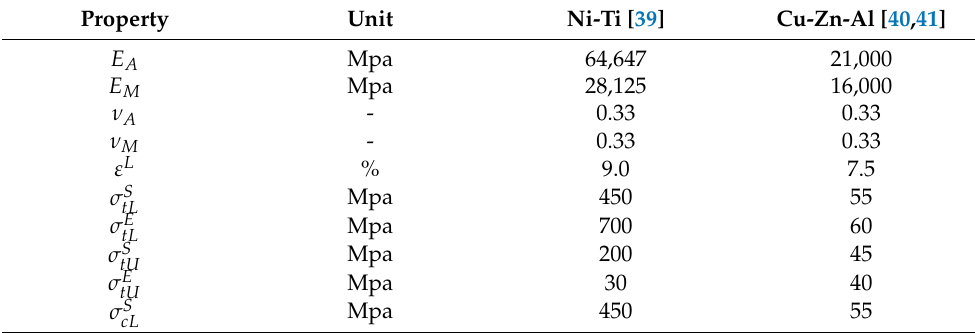
Table 2. Properties of Ni-Ti and Cu-Zn-Al SMAs used in this study.